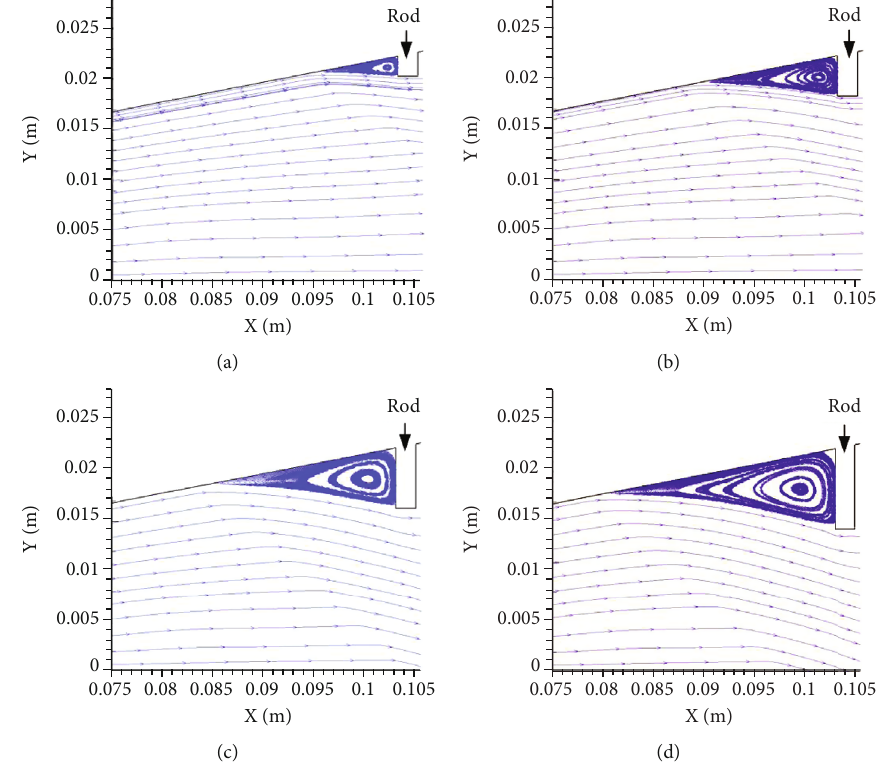
Figure 10: Streaklines for diverse rod penetration heights ( NPR = 4 : 6 and X H / R = 0 : 58 . t